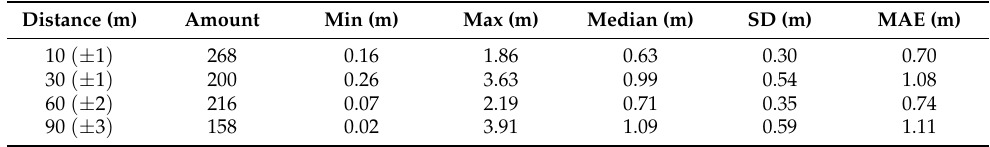
Table 5. Global Positioning